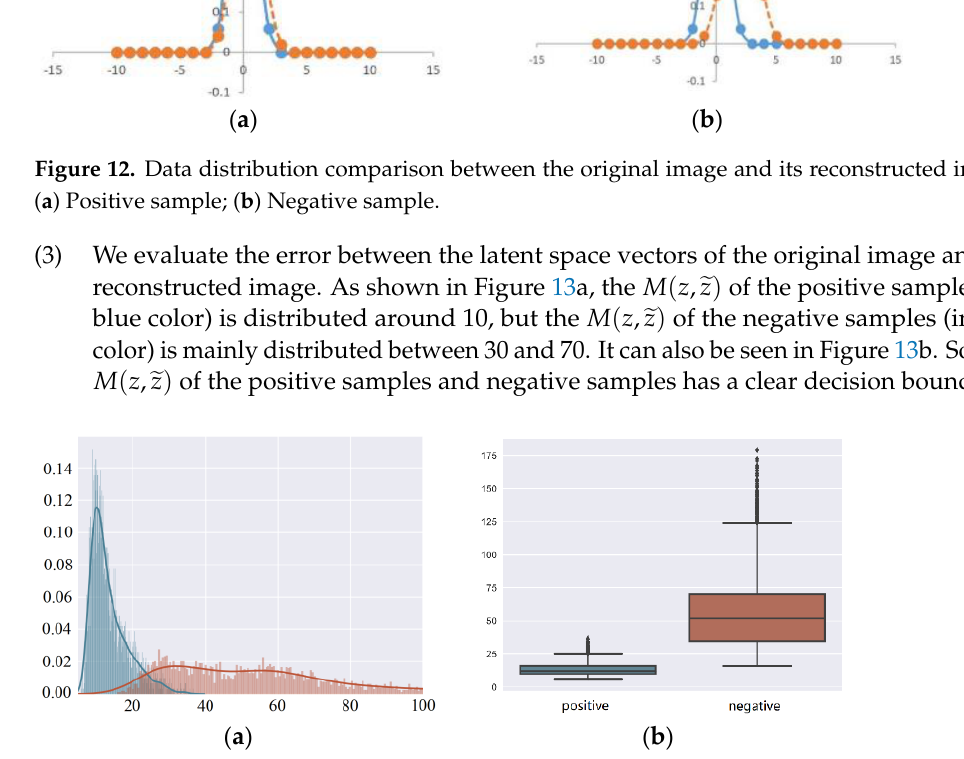
Figure 12. Data distribution comparison between the original image and its reconstructed image.